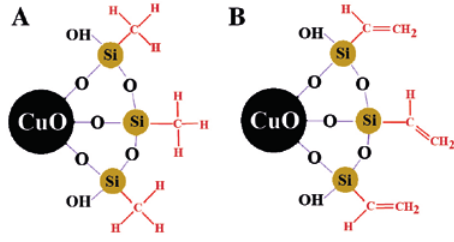
Figure 1: Modified nano CuO (A) with methyltriethoxysilane and (B) with